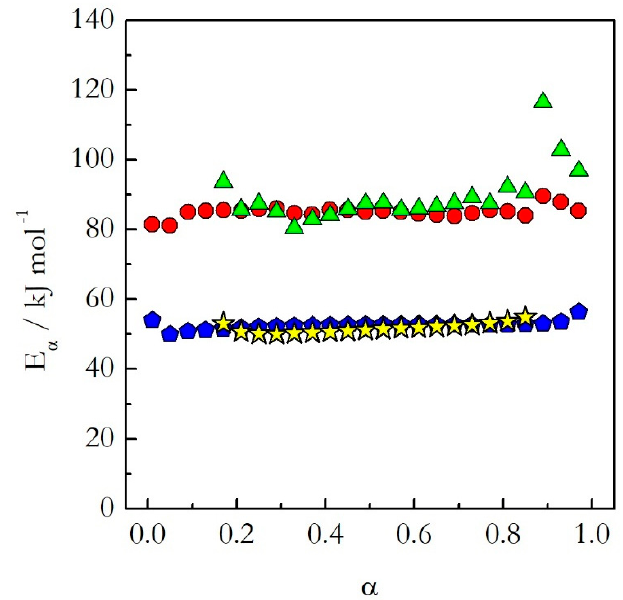
Figure 3. The activation energy as a function of conversion for the thermal decomposition of AN (heating (red circles) and cooling (green triangles)) and nonstoichiometric polymerization of DGEBA and m-PDA (heating (blue pentagons) and cooling (yellow stars)) evaluated on heating and cooling [20,22]. Partially adapted from Ref. [20] with permission from the PCCP Owner Societies.